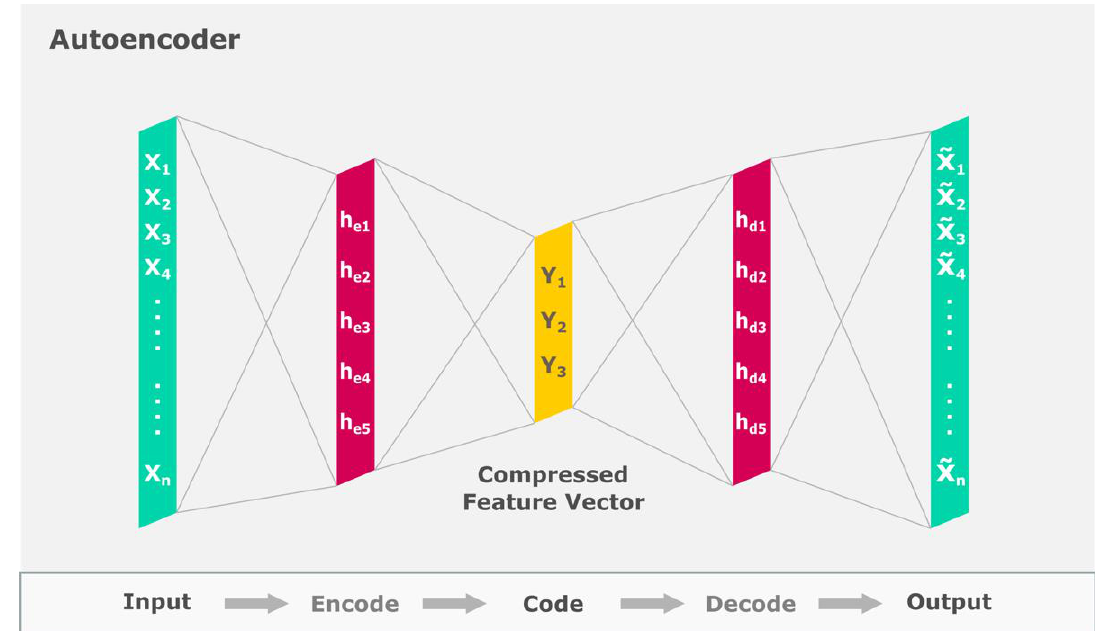
Figure 7. Illustration of the Autoencoder model.